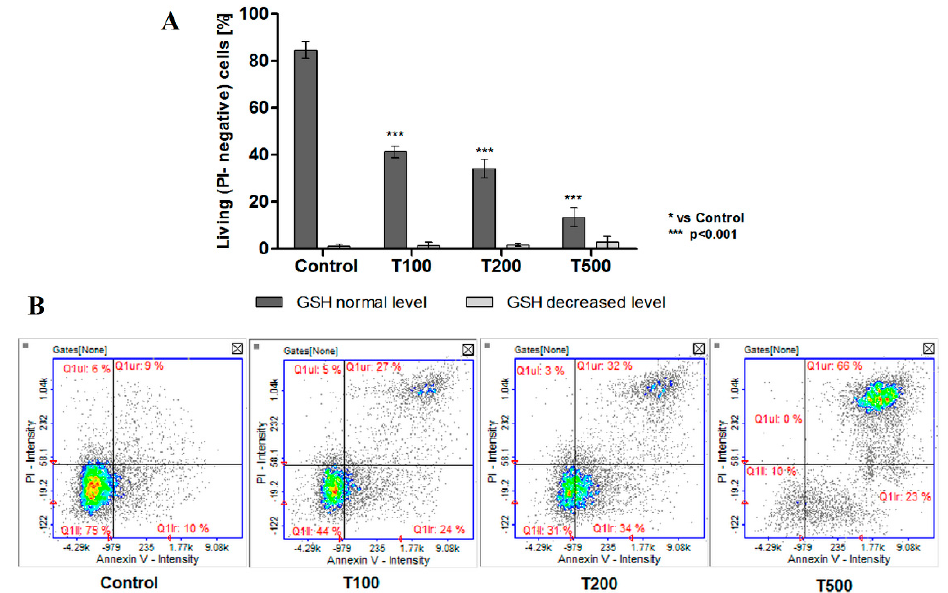
Figure 7. ( A ) Thiols levels in RPMI 8226 cells treated with teriflunomide (T) (100–500 µM) or DMSO as vehicle in control cultures based on image cytometry analysis. Scatter plots show the VB-48™ intensity versus the intensity of PI. Values were presented as mean ± SD derived from three independent experiments. ( B ) The results show one representative experiment of three independently performed. Q1II—PI negative cells with decreased GSH level, Q1Ir—healthy cells, Q1ur—dead cells.